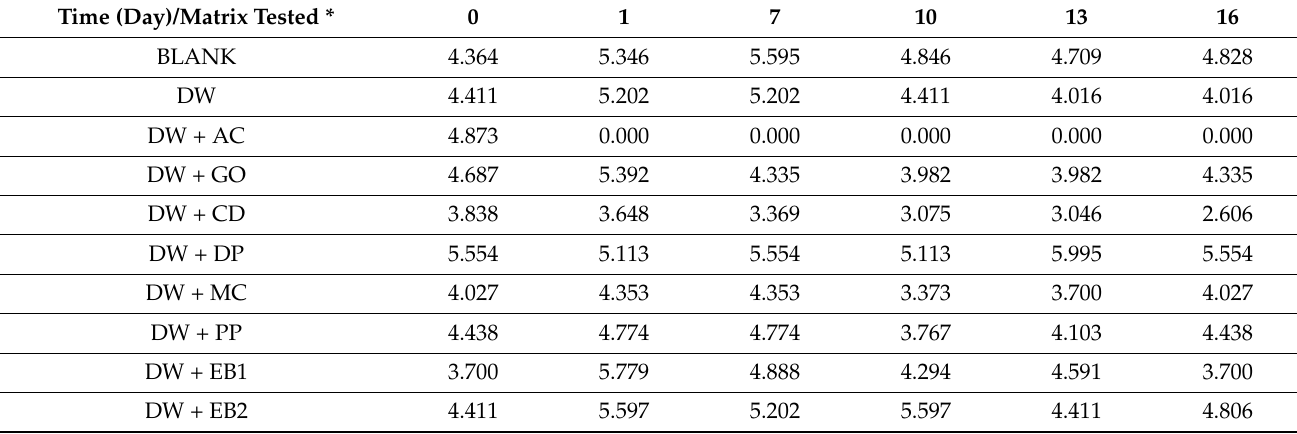
Table 3. Quantitative data of Brilliant Blue concentration (mg L − 1 ) measured in presence of different active matrices during 16 day test (involving duckweed water